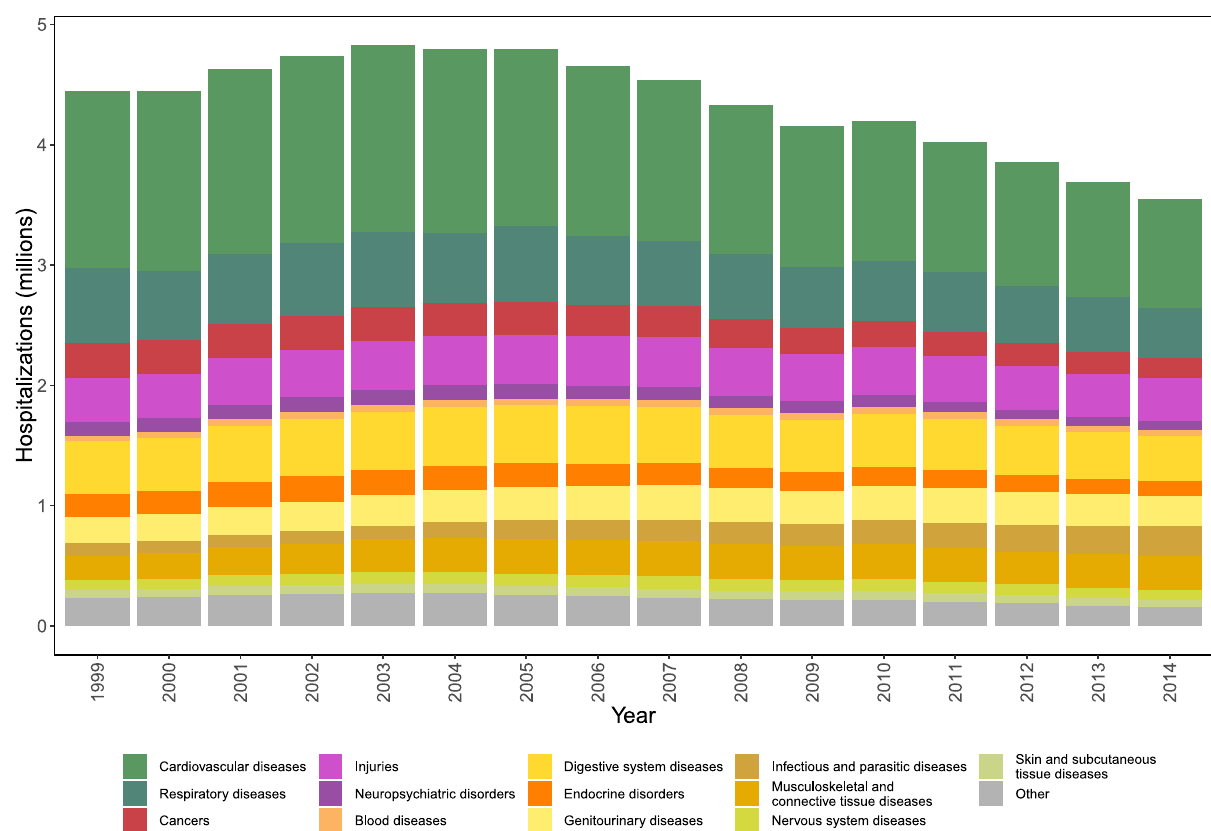
Fig. 2 Annual Medicare hospitalizations by cause. Number of Medicare hospitalizations by year and cause of hospitalization for counties with at least one tropical cyclone exposure for 1999 –